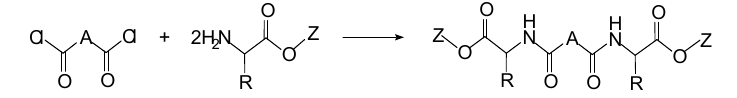
Figure 23. Synthesis of DABA (Z = H) and DABA-M (Z = CH Z = H or CH